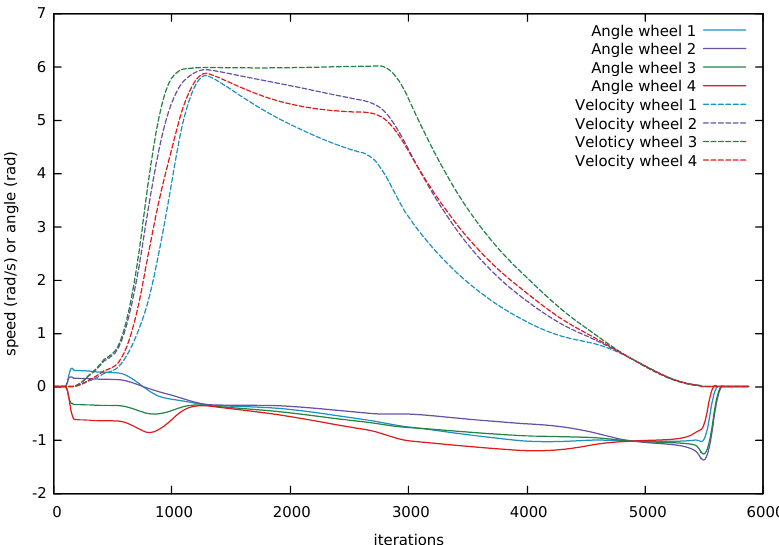
Figure 7. An example output driving from a start pose to a goal pose showing the heading and velocity of all four steer and drive units. In the beginning, the steering wheels all have an angular heading of zero. To allow the vehicle to start driving at an arbitrary direction, we utilize the feedback given by the platform to ensure that all wheels are aligned before the velocity is applied. When the vehicle has reached its goal the heading angles is set back to zero by the internal